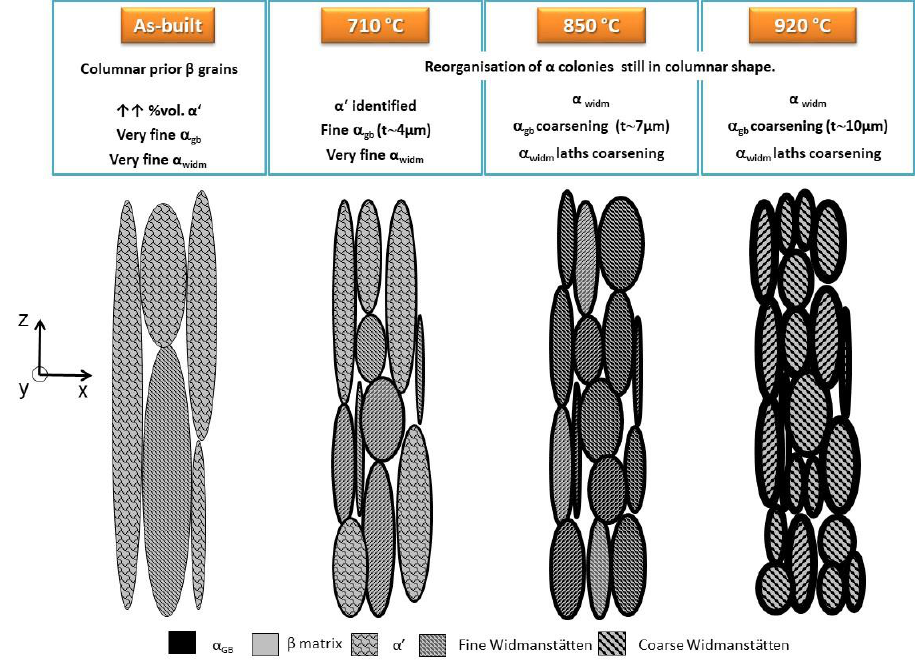
Figure 16. Schema of the evolution of the microstructure of Ti-6Al-4V WAAM samples as-built, and after the application of different heat treatments.